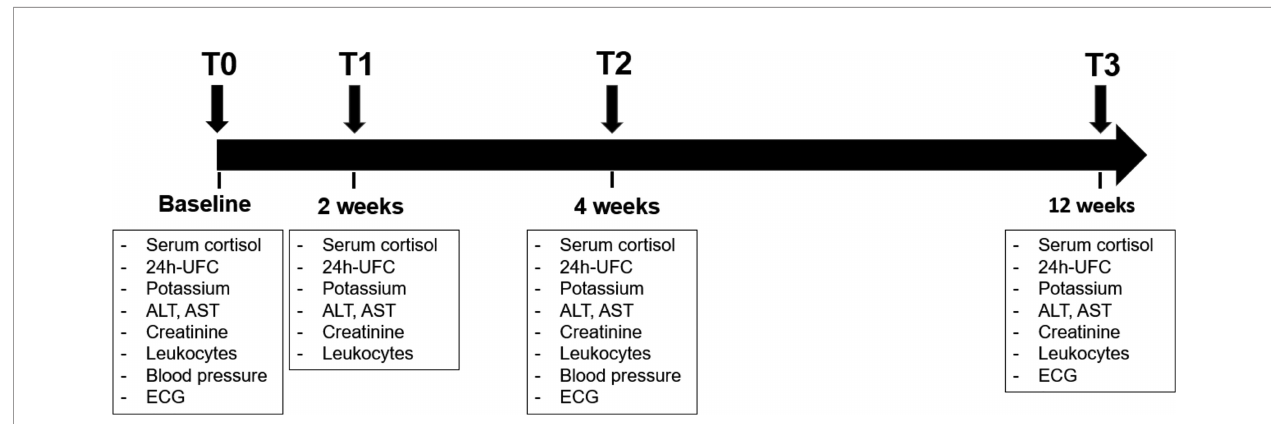
FIGURE 1 | Timeline of the study with description of follow-up visit. The data analysis was performed at baseline (T0), after 2 weeks (T1), after 4 weeks (T2) and after 12 weeks (T3). ALT, alanine transaminase; AST, aspartate aminotransferase; Crea, creatinine; ECG, electrocardiography; GGT, gamma-glutamyltransferase; K, potassium; LDL, low density lipoprotein; UFC, urinary free